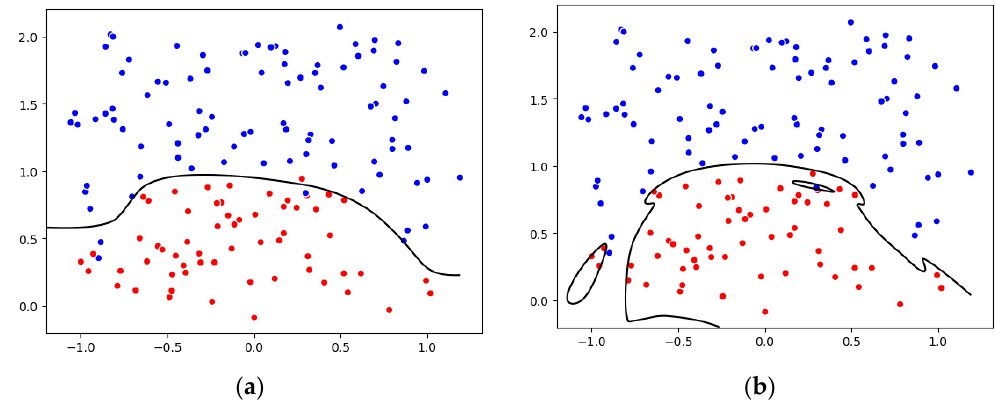
Figure 7. Synthesize two-dimensional data to illustrate regularization, ( a ) normal, ( b ) overfitting.